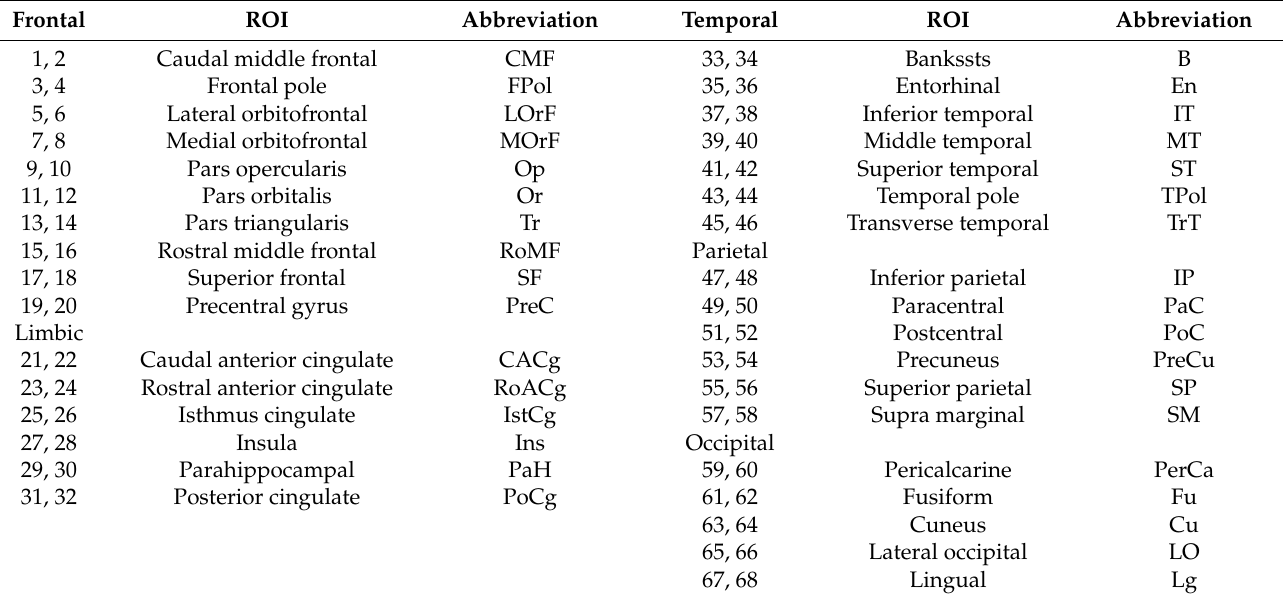
Figure 1. The image processing procedure. Table 2. Regions in the Desikan–Killiany (DK)